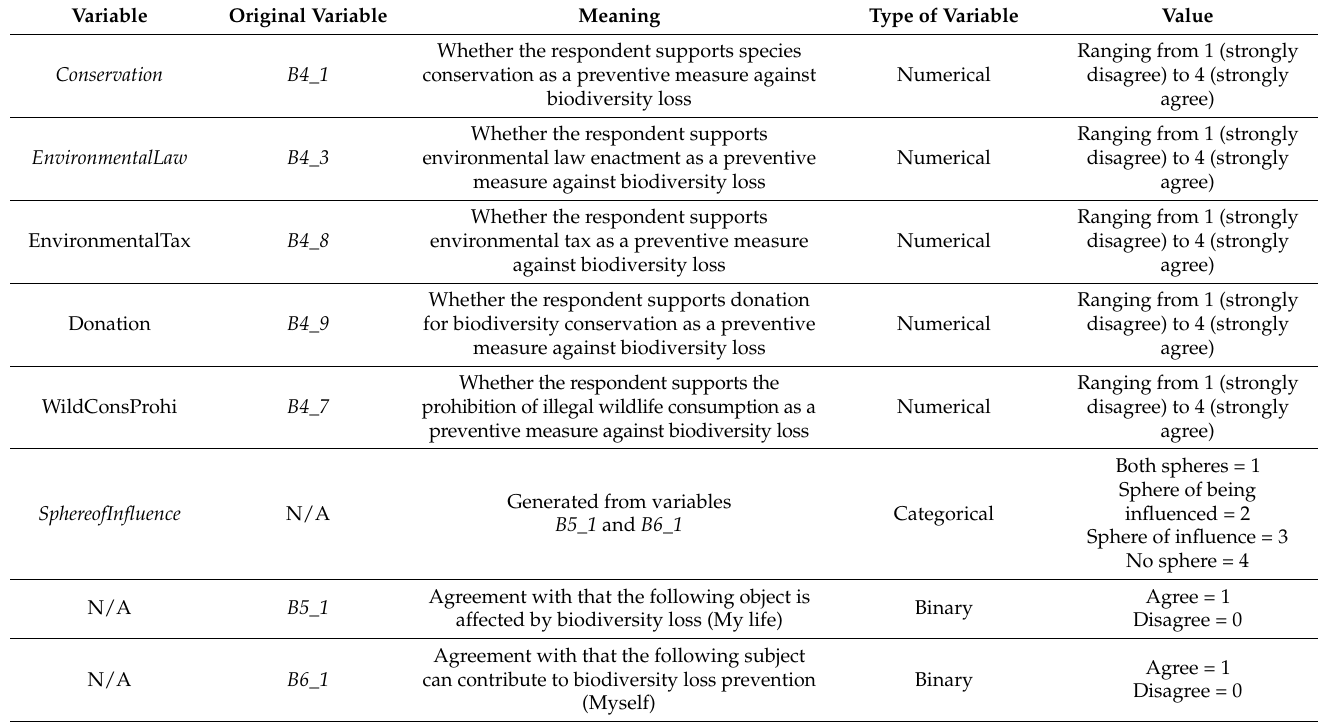
Table 2. Variable